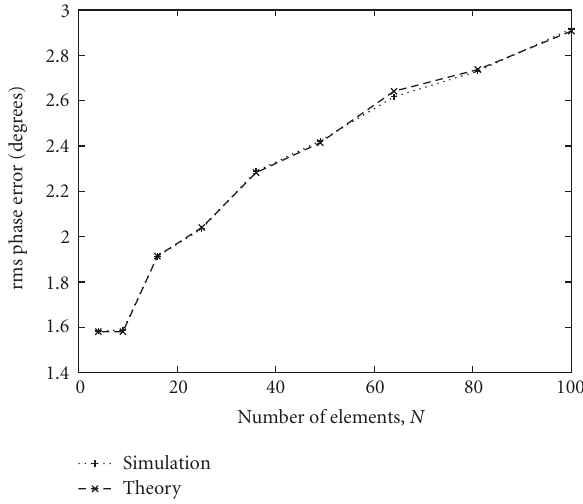
Figure 23: The theoretical prediction of overall array phase cali- bration accuracy based upon the use of the coupler hardware of Section